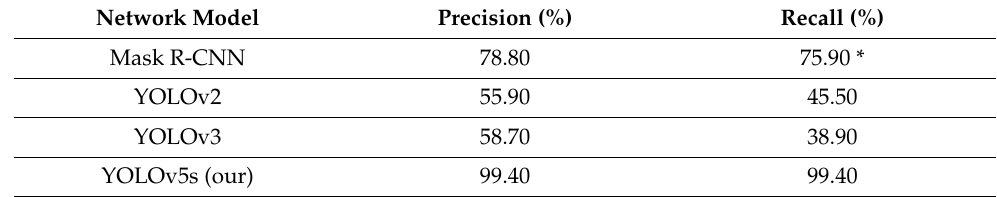
Table 4. Performance Comparison of End-to-End Detection Algorithms for Grape